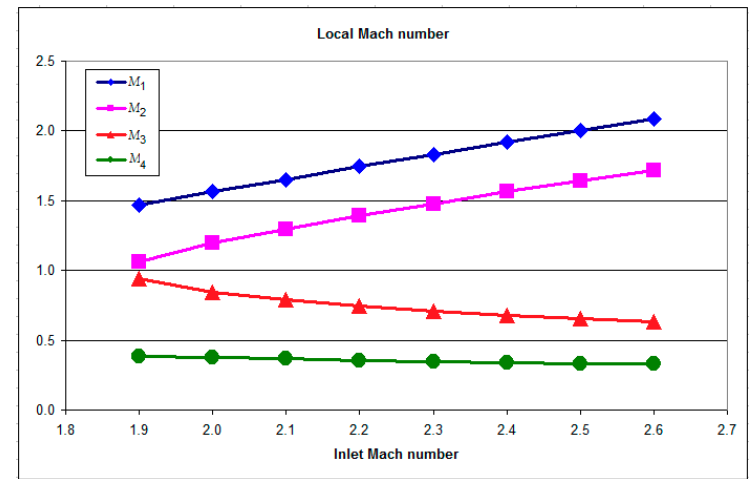
Figure 5. Local values of the Mach number in the following cross-sections: after the primary oblique shockwave ( M 1 ), after the secondary oblique shockwave ( M 2 ), after the normal shockwave ( M 3 ), and on the combustion chamber inlet cross-section ( M 4 ).